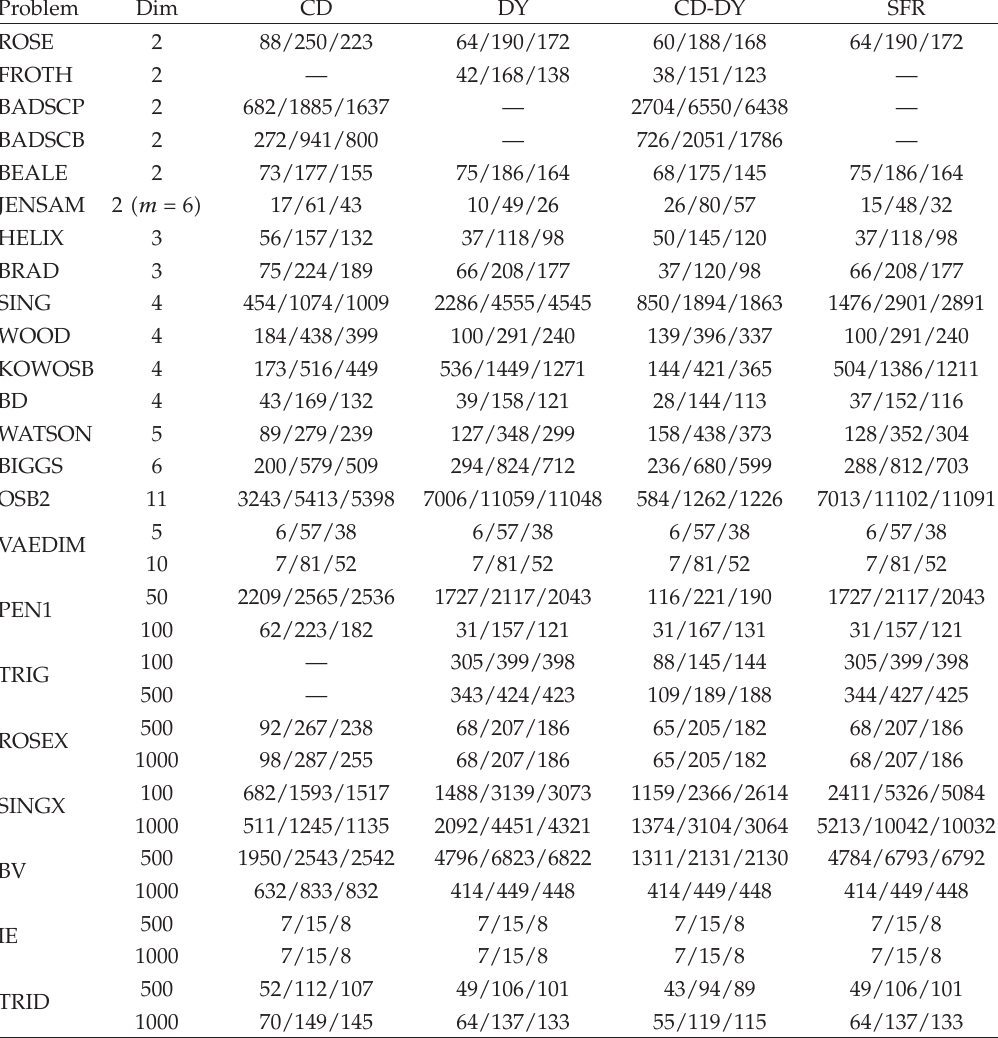
Table 1: The performance of the CD method, DY method, CD-DY method, and SFR method.